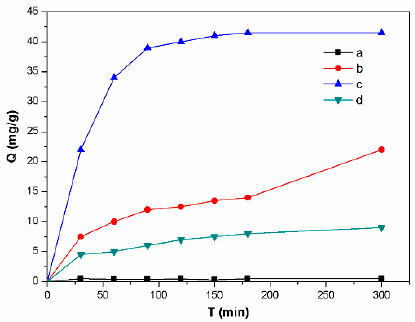
Figure 9. The adsorption rates of the ( a ) control and ( b–d ) lignin-based carbon materials in 40 wt % ZnCl 2 solution using ( b ) microwave, ( c ) ultrasound, and ( d ) UV irradiation, respectively.